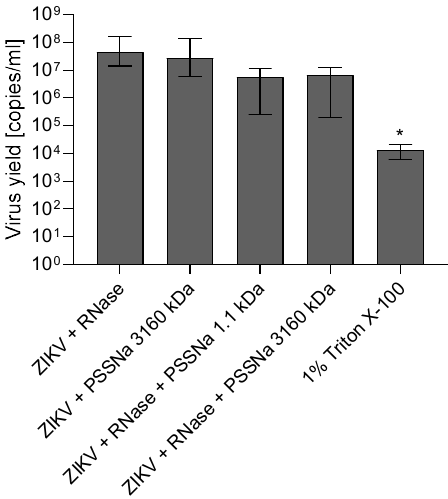
Figure 6. PSSNa does not disrupt ZIKV particle integrity. ZIKV H/PF/2013 stock was incubated with 1 mg/mL PSSNa, then released RNA was digested with 100 µg/mL RNase. 1% Triton X-100 was used as a positive control. Results show RT-qPCR analyses (copies of viral genome per milliliter). The results are presented as average values with standard deviation (error bars) of at least three replications. An asterisk (p < 0.05) indicates values that are significantly different from the control.